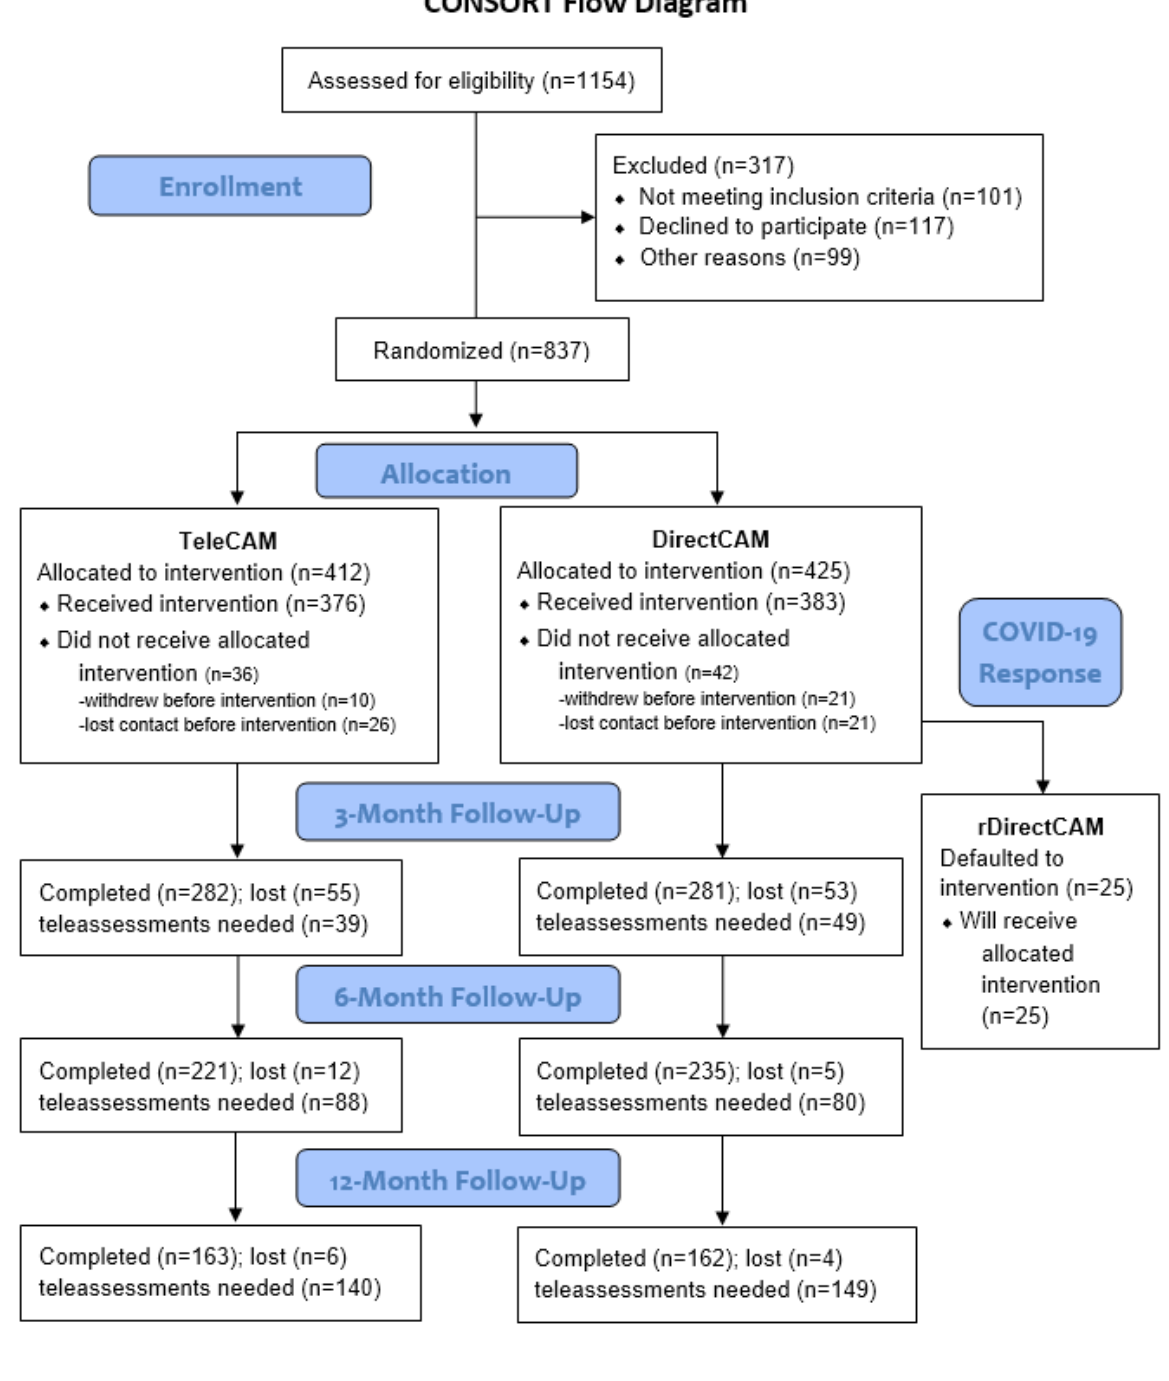
Figure 6. Modified CONSORT (Consolidated Standards of Reporting Trials) diagram reporting the number of teleassessments that need to be completed and participants who need to undergo rDirectCAM. COVID-19: coronavirus